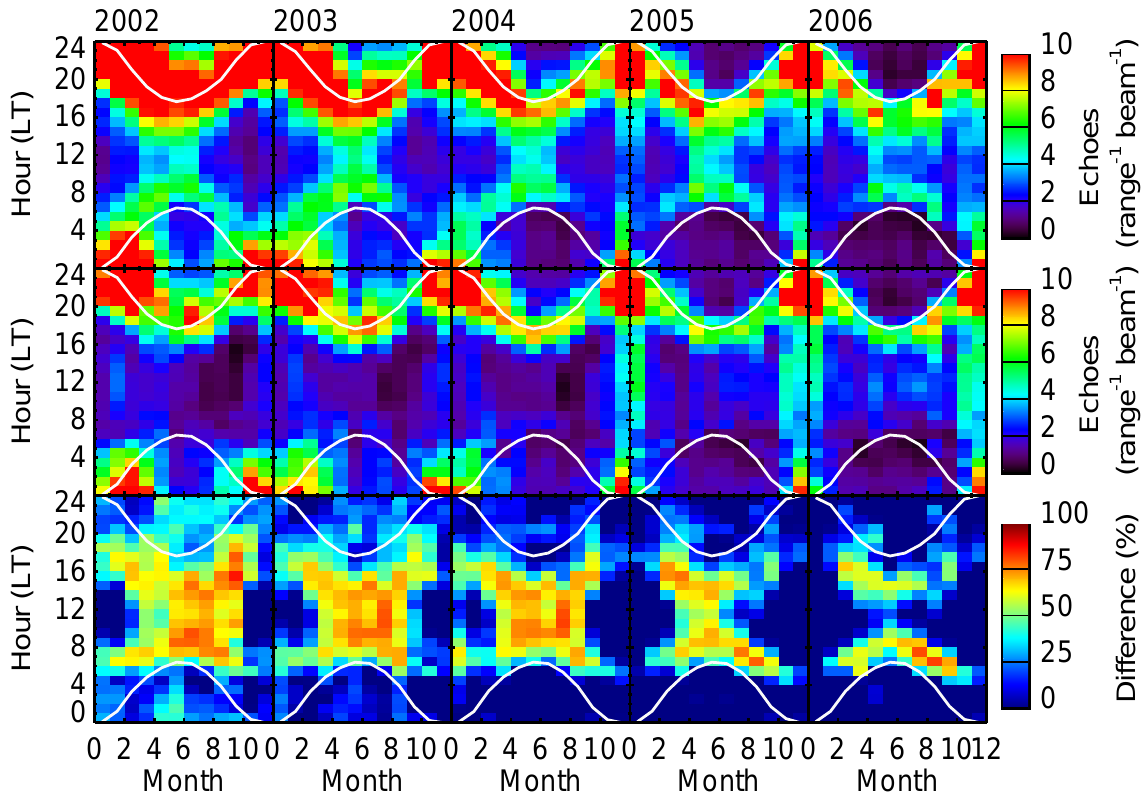
Fig. 7. Comparison of TIG echo occurrence statistics for ranges 765–3015km (first row) and 765–1260km (second row). The format of each panel is the same as in Fig. 3. The third row shows percentage difference between the two sets of